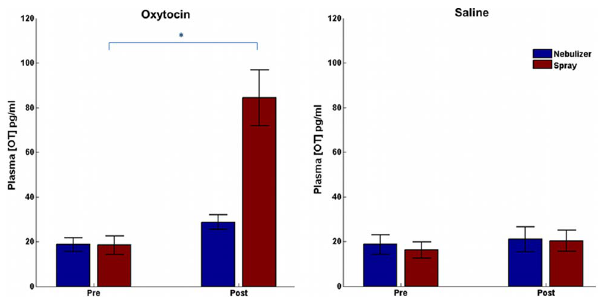
Figure 2. Plasma Oxytocin (OT) concentration. Values shown are the mean 6 SEM (n=15). A. OT concentration in plasma before and 40 minutes after OT intranasal administration, * p , .05. B. OT concen- tration in plasma before and 40 minutes after intranasal saline administration.